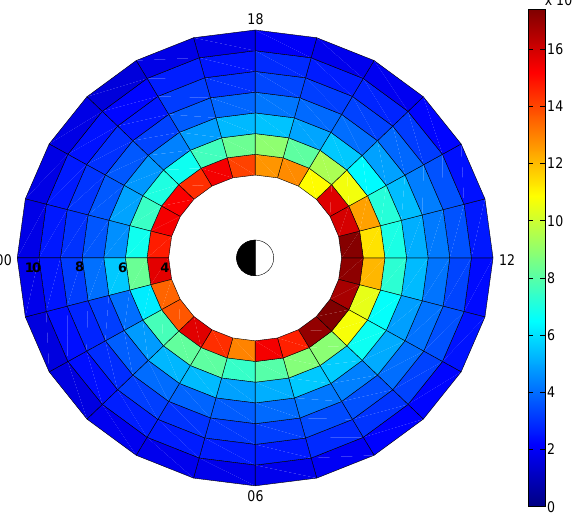
Fig. 7. Probability of having plasmasphere observations in each L − MLT bin, based on the 5222 plasmasphere passes in our study. L varies between 4 and 11 R E .